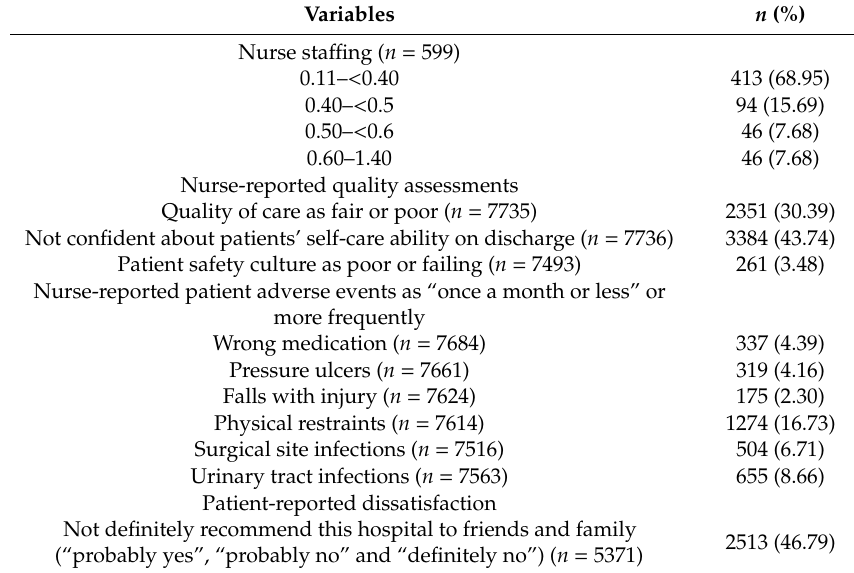
Table 3. Description of nurse sta ffi ng, nurse-reported quality assessments, nurse-reported patient adverse events and patient-reported dissatisfaction a